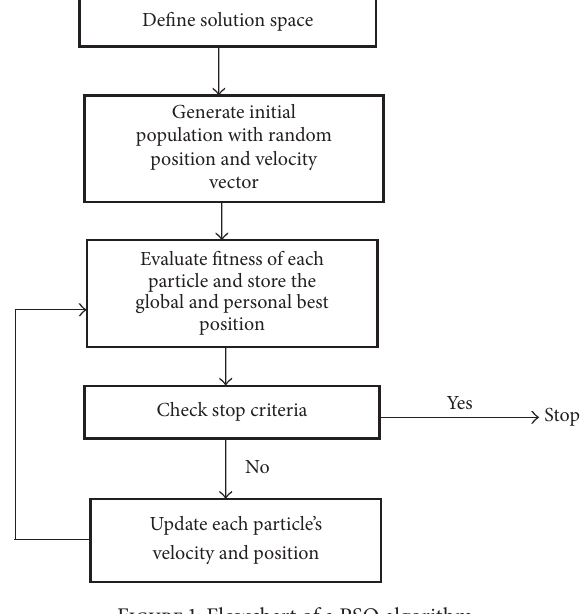
Figure 1: Flowchart of a PSO algorithm.